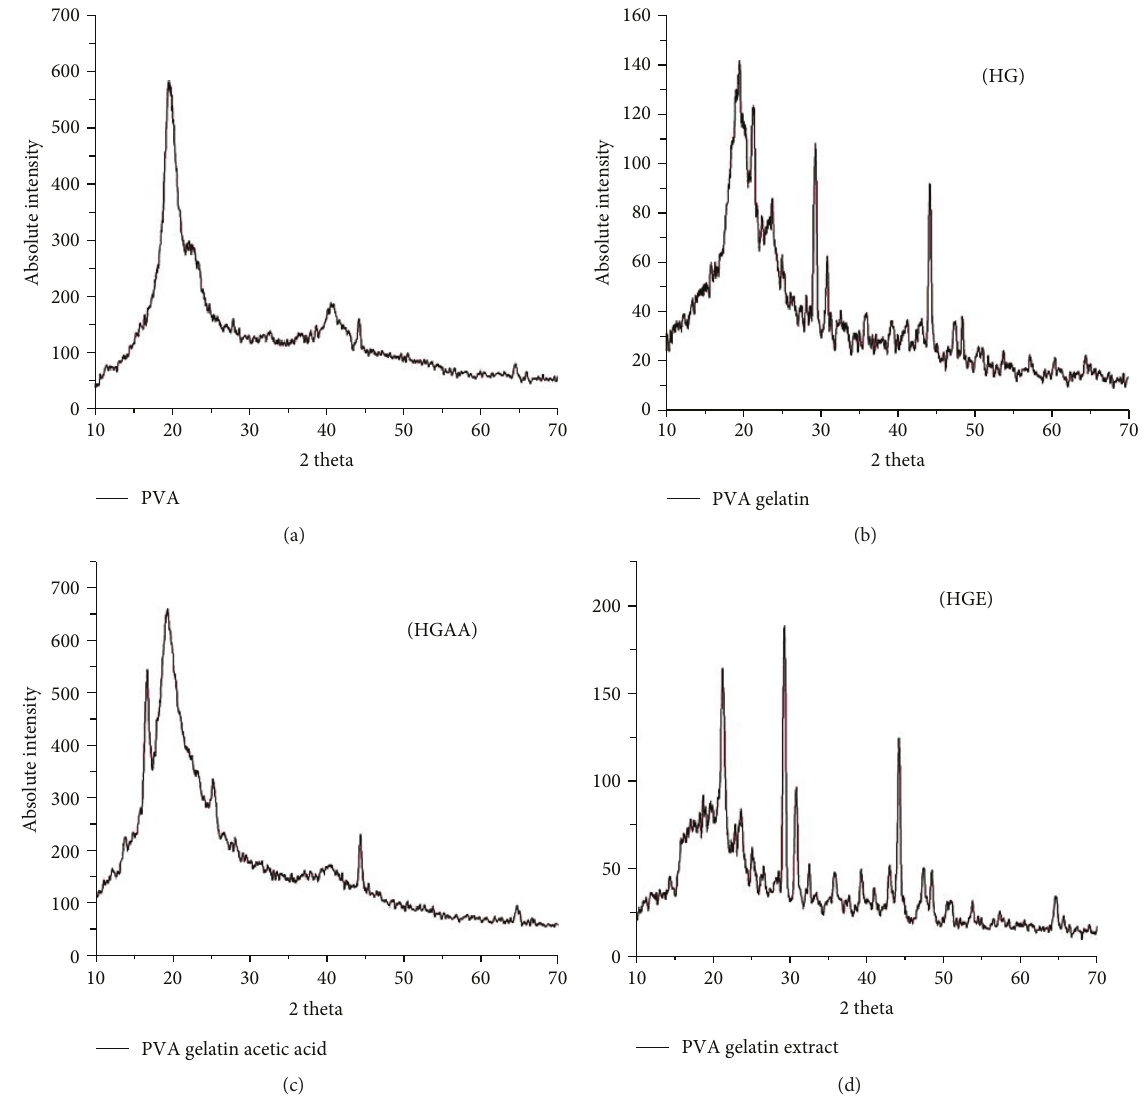
Figure 3: X-ray di ff ractograms of the prepared hydrogels: (a) PVA; (b) HG; (c) HGAA; (d) HGE. Table 1: Absolute intensities of the main peaks at 2 θ from XRD patterns of the prepared